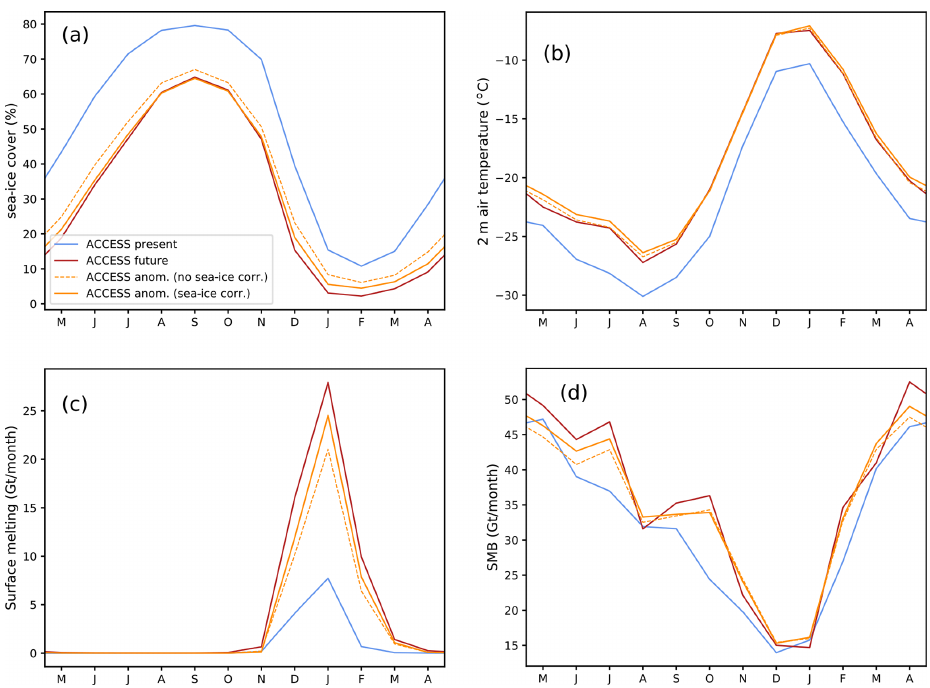
Figure 10. Mean 21-year seasonal cycle of (a) domain-averaged sea-ice concentration, (b) 2m air temperature, (c) surface melt, and (d) SMB, with (b–d) integrated over the seven glacial drainage basins from Getz to Abbot (including both ice shelf and grounded ice). The blue and dark-red lines correspond to the present and true future based on ACCESS-1.3, respectively. The orange lines represent the results of the projected future, applied with (solid) and without (dashed) sea-ice iterative correction (see Sect.